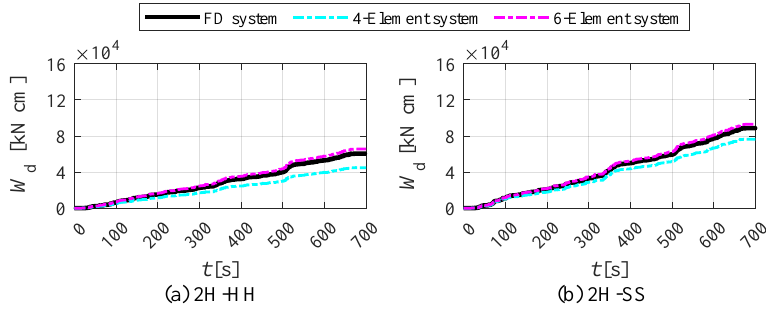
Figure 27. Comparison of the accumulated energy dissipation of the VE dampers (across-wind). Figure 28 illustrates the comparison of the total accumulated energy dissipation = W ( t ) when subjected to the across-wind. It compares the differences in (a) the W 0 d,t0 d 4-element and (b) the 6-element with the FD system. Figure 28a expresses that the difference in the total accumulated energy dissipation increases as the storage stiffness of the damper increases, and it is under-evaluated. Figure 28b expresses that the 6-element system has a similar trend as the 4-element system, but the difference is over-evaluated. Total accumulated energy dissipation subjected to across-wind has a similar tendency as along- wind, but the results are